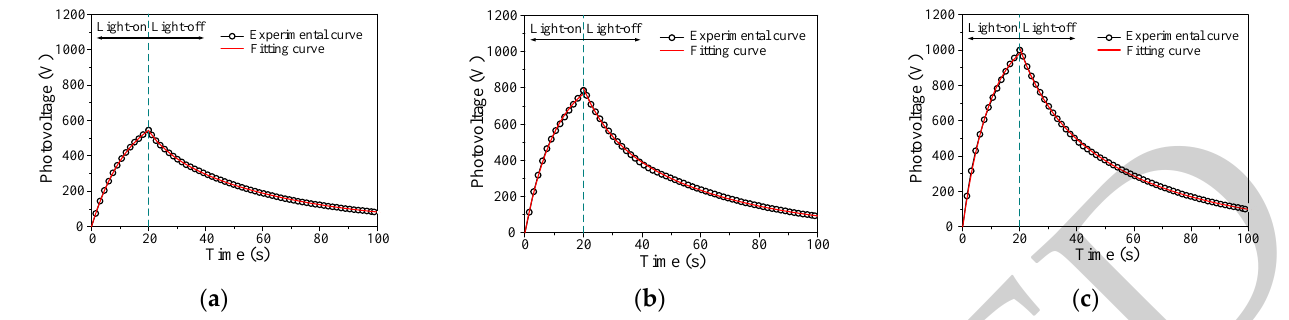
Figure 4. The experimental and fitting curves of the photovoltage of PLZT ceramic under irradiation of different light intensities. ( a ) Light intensity is 20 mW/cm 2 . ( b ) Light intensity is 40 mW/cm 2 . ( c ) Light intensity is 60 mW/cm 2 .